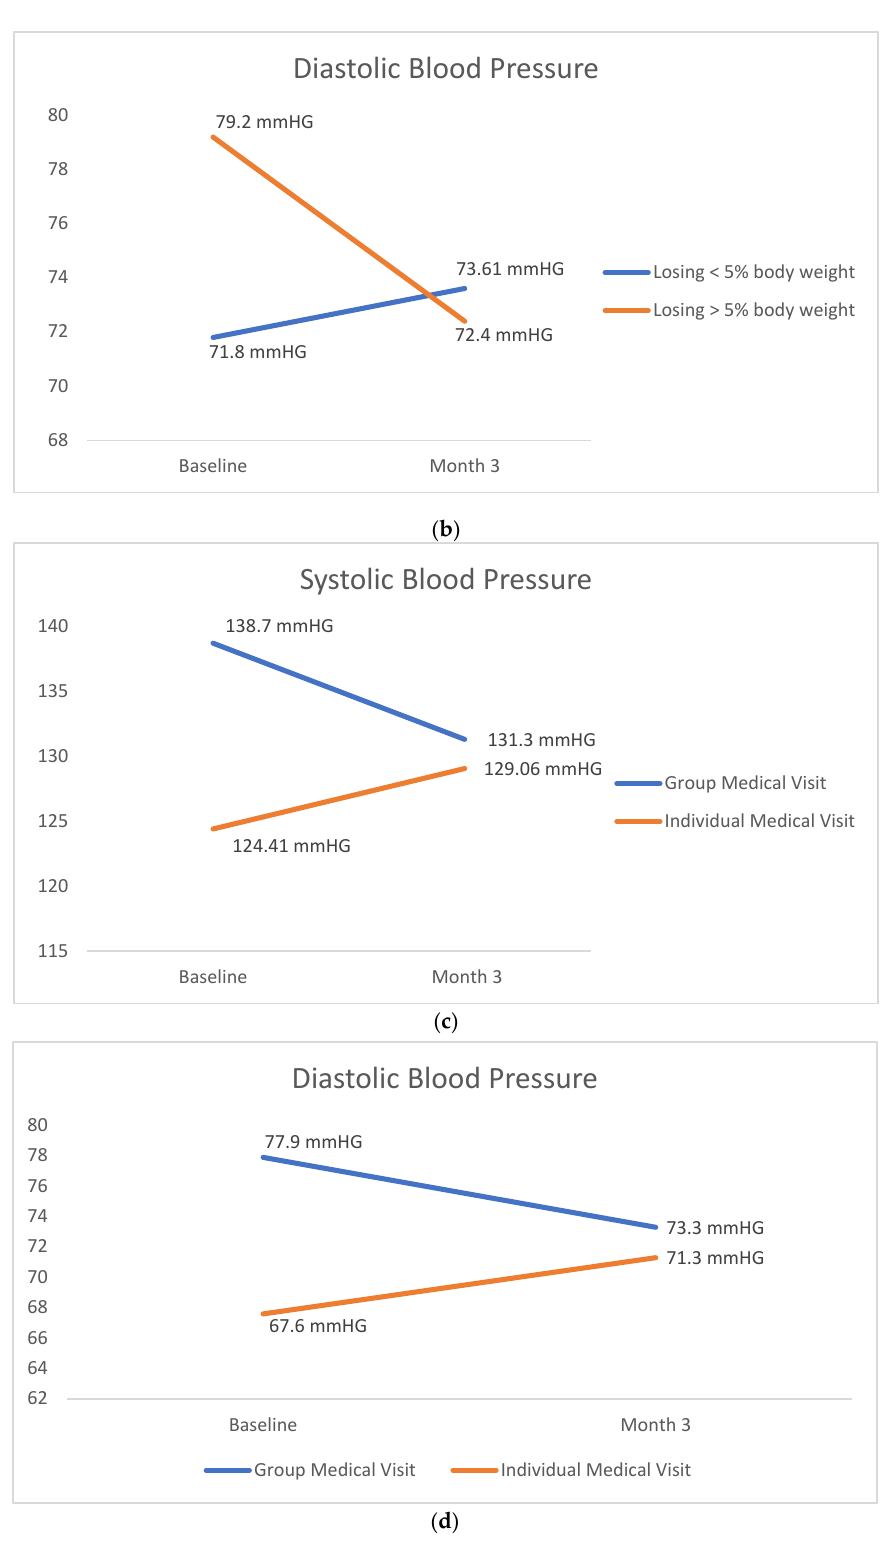
Figure 2. ( a ) Changes in Systolic Blood Pressure by % Weight Loss. ( b ) Changes in Blood Pressure by % Weight Loss. ( c ) Changes in Systolic Blood Pressure by Visit Type. ( d ) Changes in Blood Pressure by Visit Type.